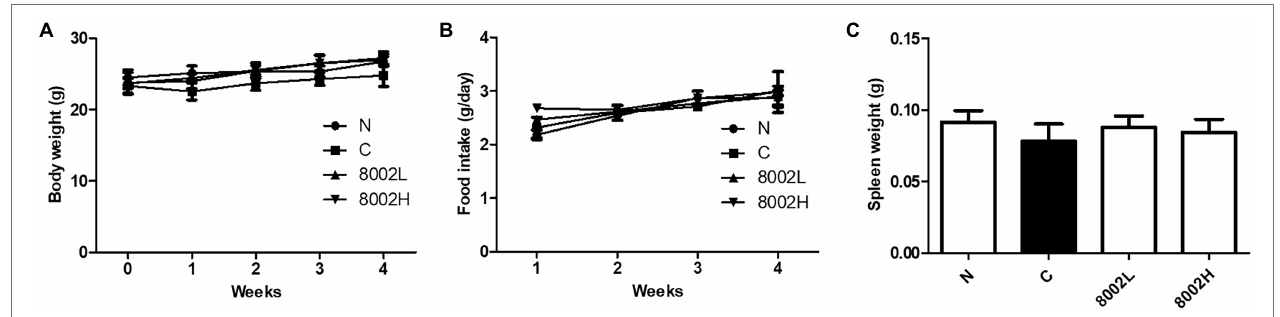
FIGURE 5 | Effect of HY8002 administration on (A) body weight, (B) food intake, and (C) spleen tissue mass in the kanamycin-treated mice. The results are expressed as the mean ± SEM. N, normal group ( n = 8); C, kanamycin administration group ( n = 8); 8002L, kanamycin with 1.0 × 10 8 CFU/kg/day HY8002